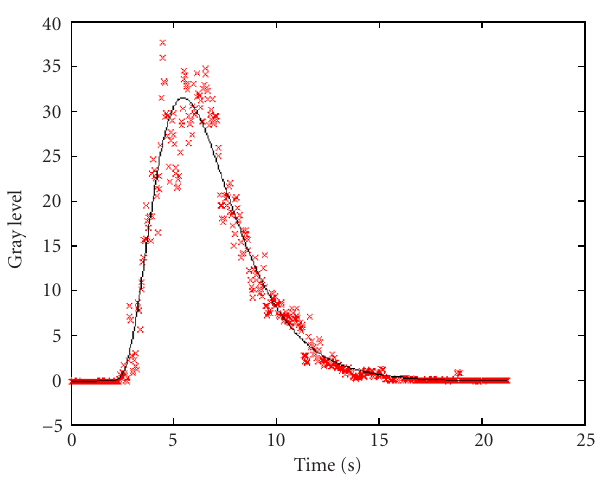
Figure 11: LDRW model fit of a DTC, ρ 2 = 0 . 97.